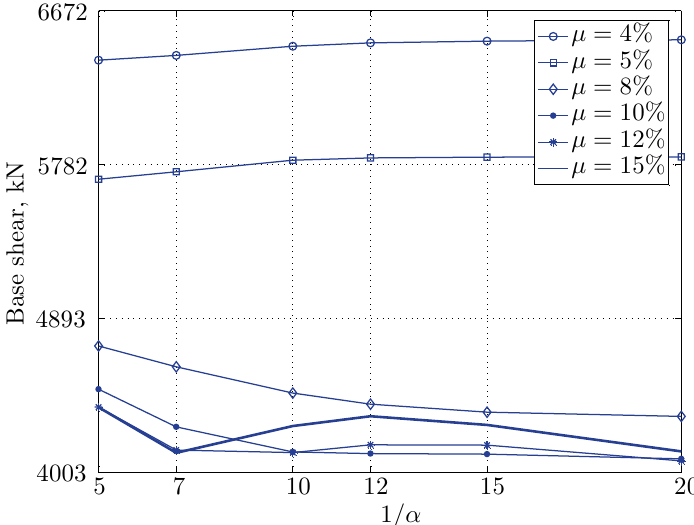
Figure 15. Maximum base shear for various isolation system parameters (El Centro 1979).